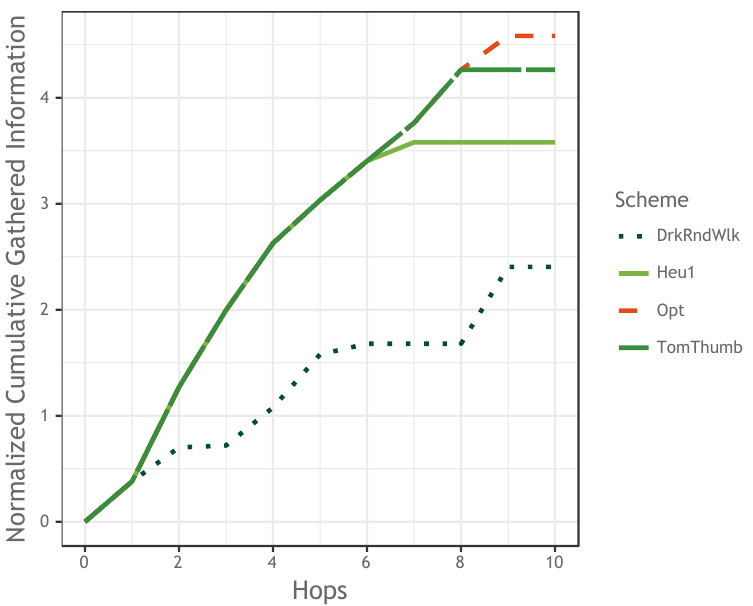
Figure 6. Normalised cumulative gathered information as a function of time round (i.e., hops) comparison among the proposed TT and alternative approaches for N c = 24 and ND = 0.3